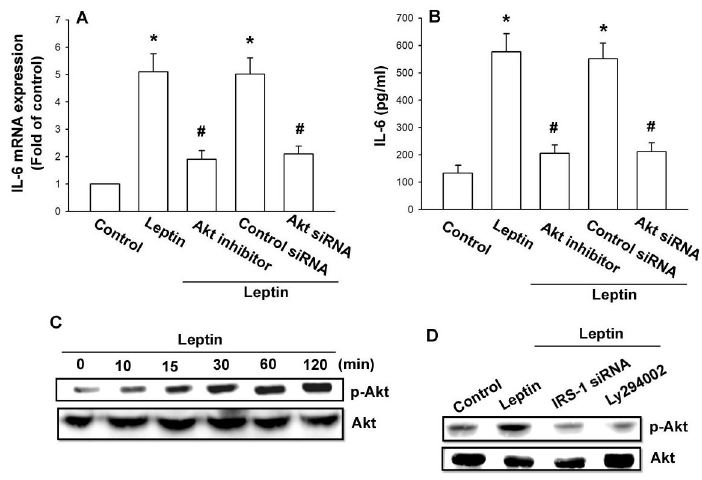
Figure 4. The Akt signaling pathway is involved in the potentiating action of leptin. (A and B) OASFs were pretreated for 30 min with Akt inhibitor or transfected with Akt siRNA for 24 h, followed by stimulation with leptin for 24 h. Media and total RNA were collected, and the expression of IL-6 was examined by qPCR and ELISA assay (n=4). (C) OASFs were incubated with leptin for the indicated time intervals. Total protein was collected and the phosphorylation of AKT was examined by western blotting (n=4). (D) OASFs were pretreated for 30 min with Ly294002 or transfected with IRS-1 siRNA for 24 h and then incubated with leptin (3 µM) for 60 min; Total protein was collected and the phosphorylation of AKT was examined by western blotting (n=4). Results are expressed as mean ±S.E.M. of four independent experiments. *: p < 0.05 as compared with basal level. #: p < 0.05 as compared with the leptin-treated group. doi: